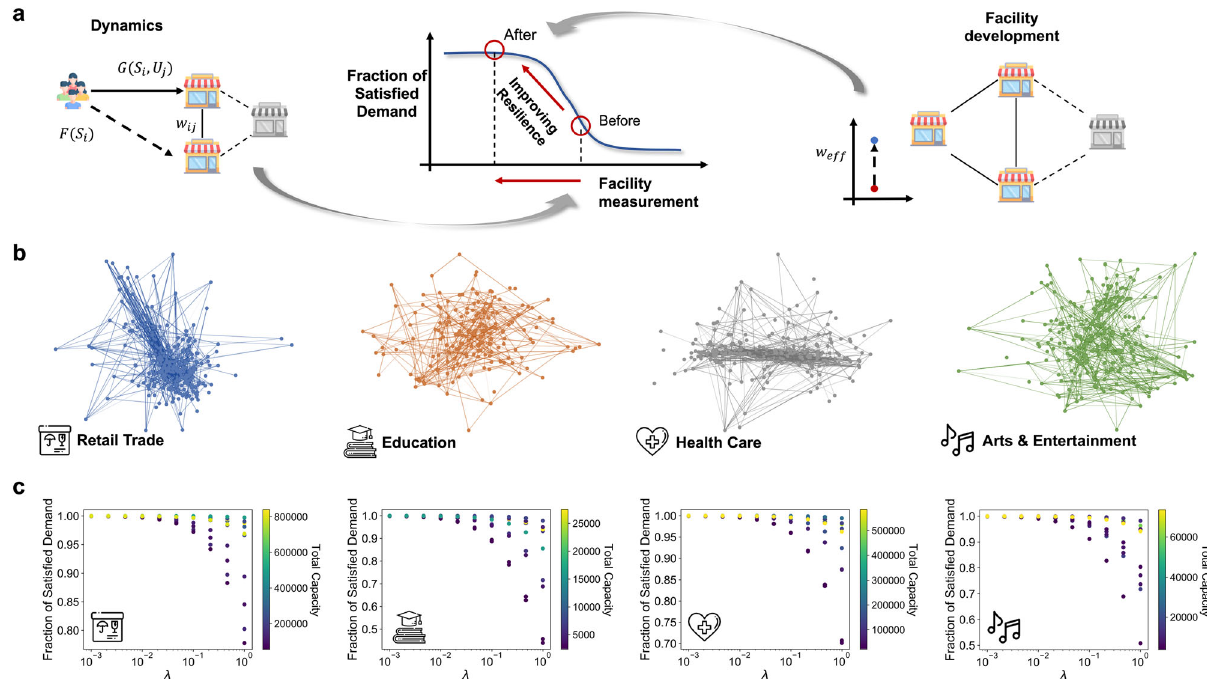
Fig. 4 Characterization and resilience analysis in population-facility (PF) networks. a A schema for our formalization of the dynamic process of population-facility interactions. The sub- fi gure on the left side shows the internal dynamics of the population ( F ( S i )) and the dynamic interactions with facilities ( G ( S i , U j )) in the empirical distribution of facilities. The sub- fi gure on the right side shows the change of facility distribution in the optimal scenario. The sub- fi gure in the center illustrates the impacts of changing facility distributions on the fraction of satis fi ed demand of the population in counties. b The facility connectivity characterized by distances for visualizing the urban facility networks. Here, we show example types of facilities in Suffolk county. The nodes are grid cells that have facilities, and the links between grid cells are created based on the connectivity through the road network. The links are visualized when the w ij is greater than a threshold. c The steady-state solutions of the resilience model based on the existing distributions of four example types of facilities with varying λ values. The total capacity is obtained by summing up all the capacities of existing facilities in a county. The color bar representing total capacities indicates different counties with different total capacities. More results are provided in Supplementary Fig.